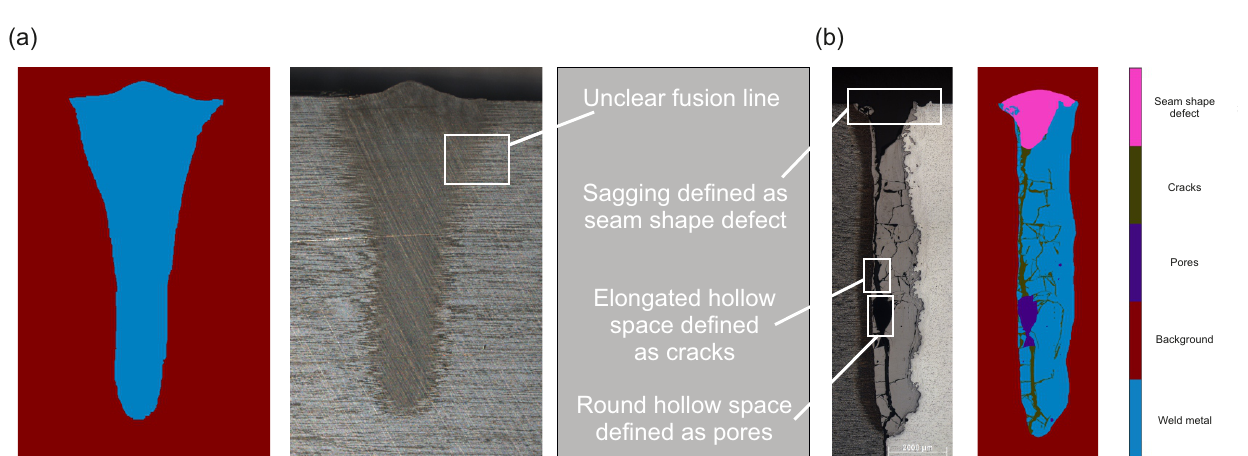
Figure 3. Ambiguous defects between weld metal and background ( a ), between porosity and cracks and seam shape defects and background ( b ).